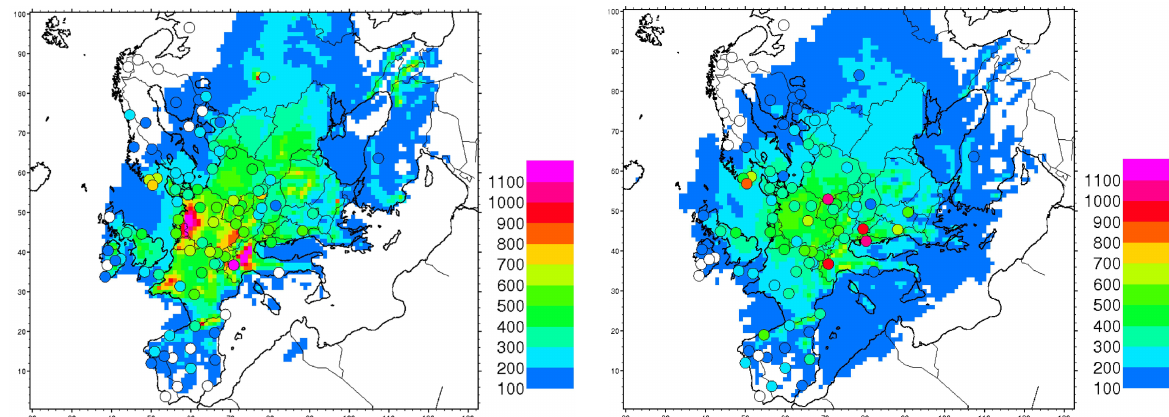
Fig. 10. Comparison of modelled and observed annual wet deposition of to the left NH x and to the right NO − NO − ). Modelled data are from the EMEP MSC-W model, observations from the EMEP network, both for the year 2001. The bullets depict 3 observations with the same colour base as the modelled field. Measured annual deposition is calculated by using the measured precipitation amount and the NO − and NH + concentration in precipitation (Simpson et al., 3 4